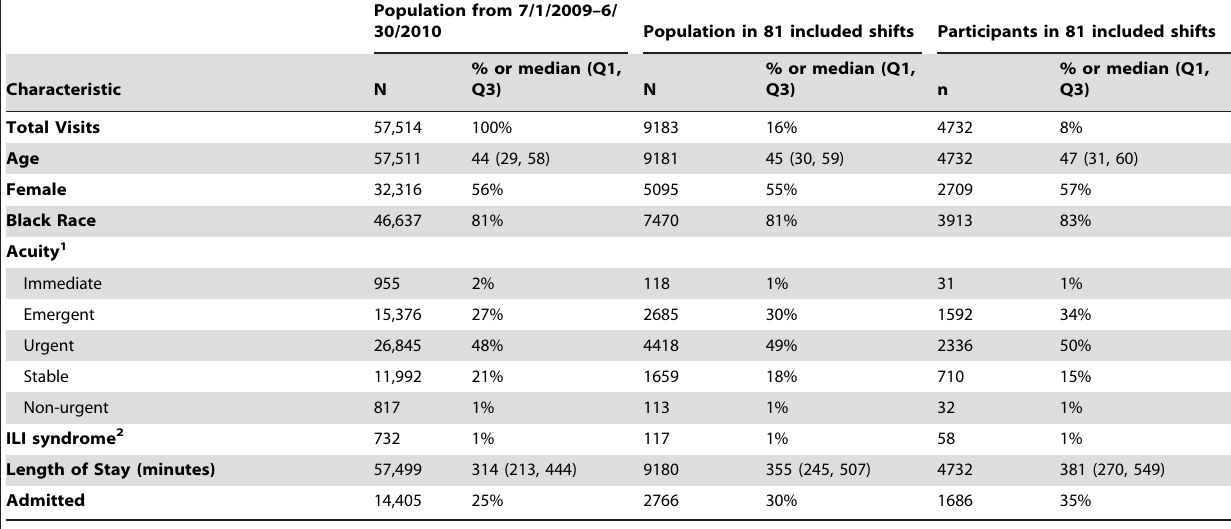
Table 1. Characteristics of patients visiting the ED, July 1 2009 to June 30 2010.